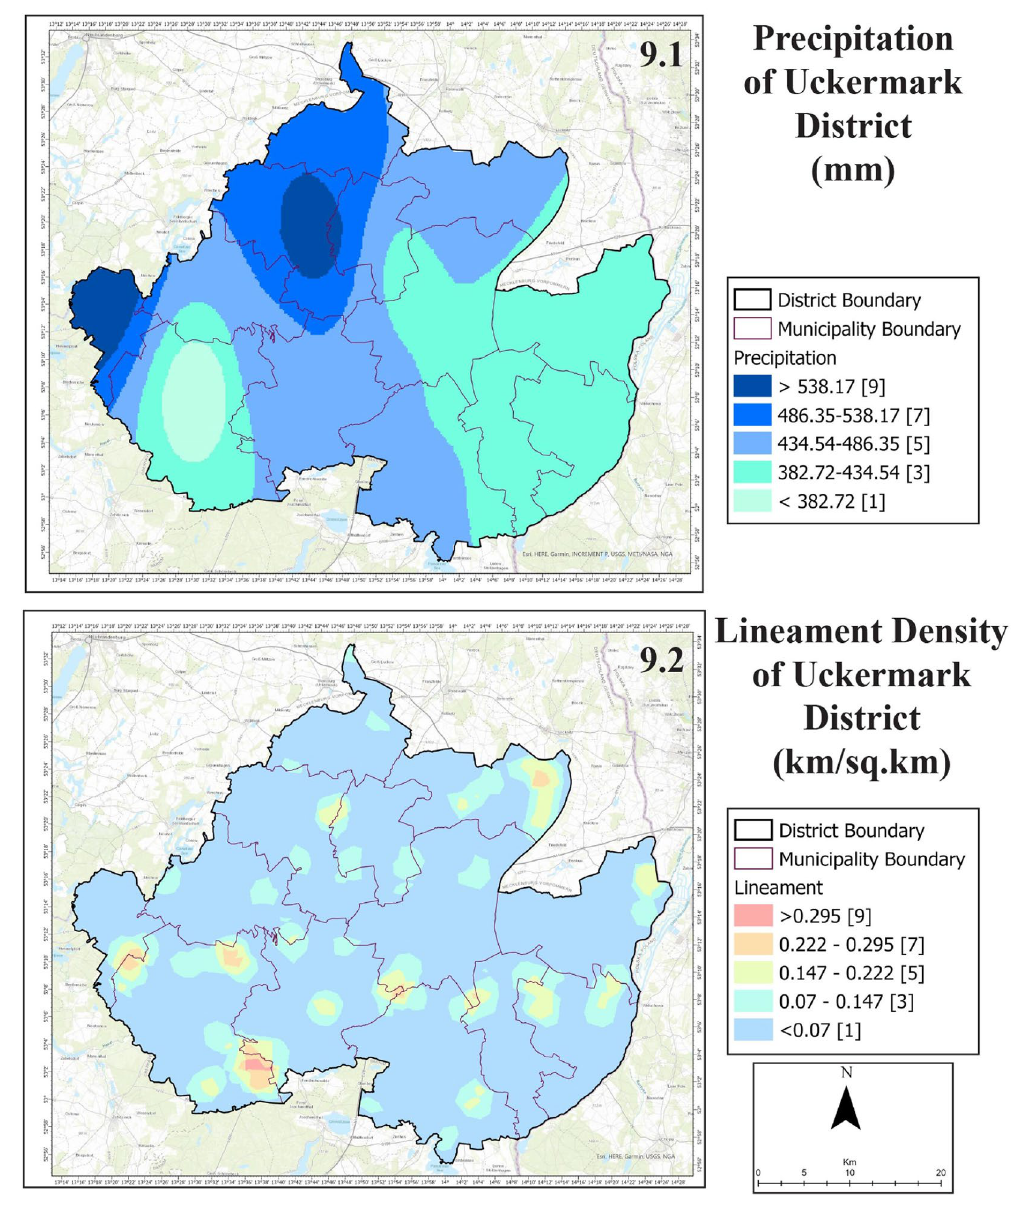
Figure 9. Precipitation (9.1) and lineament density (9.2) of Uckermark